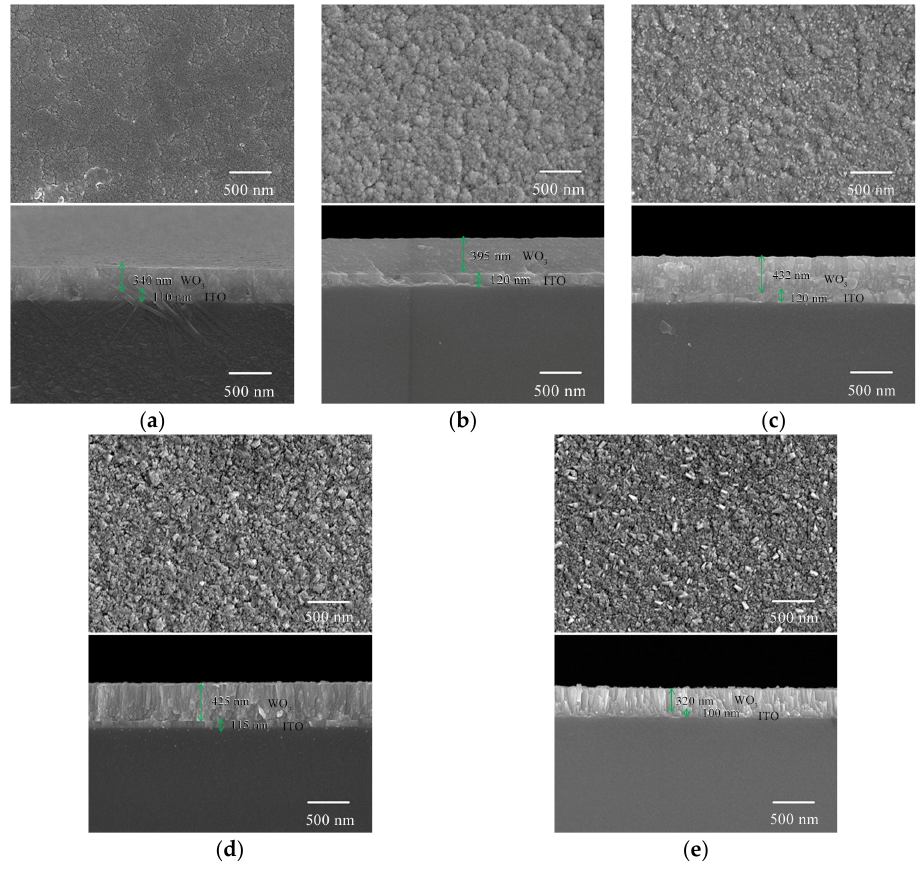
Figure 3. Surface and cross section scanning electron microscope (SEM) images of WO 3 thin films deposited at different substrate temperatures ( a ) 300 K, ( b ) 473 K, ( c ) 573 K, ( d ) 673 K and ( e ) 743 K.